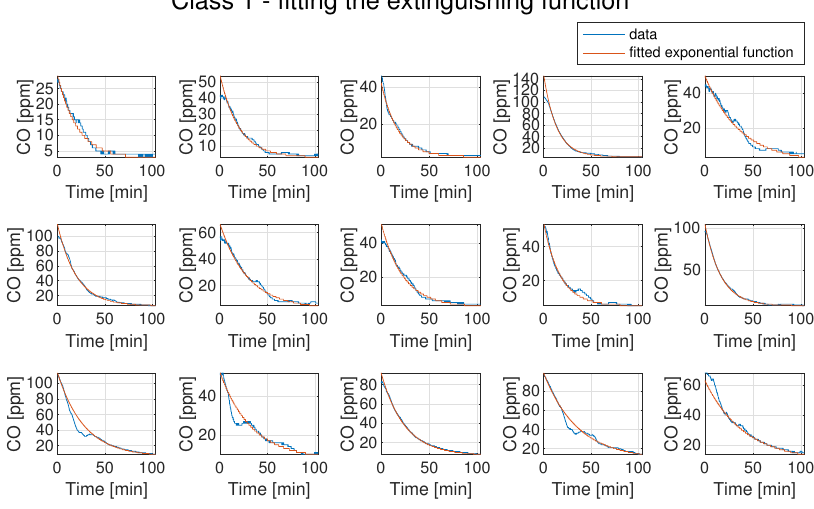
Figure A8. The results of fitting of the deterministic function to the extinguishing process—Part